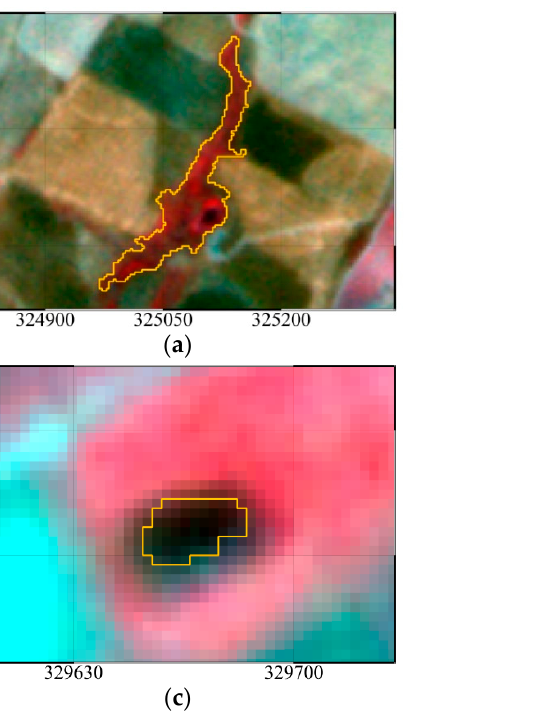
Table 5. Normalized error matrix of the NN classification. When the achieved normalized accuracy is higher than that achieved by the RF classifier, its value is underlined.